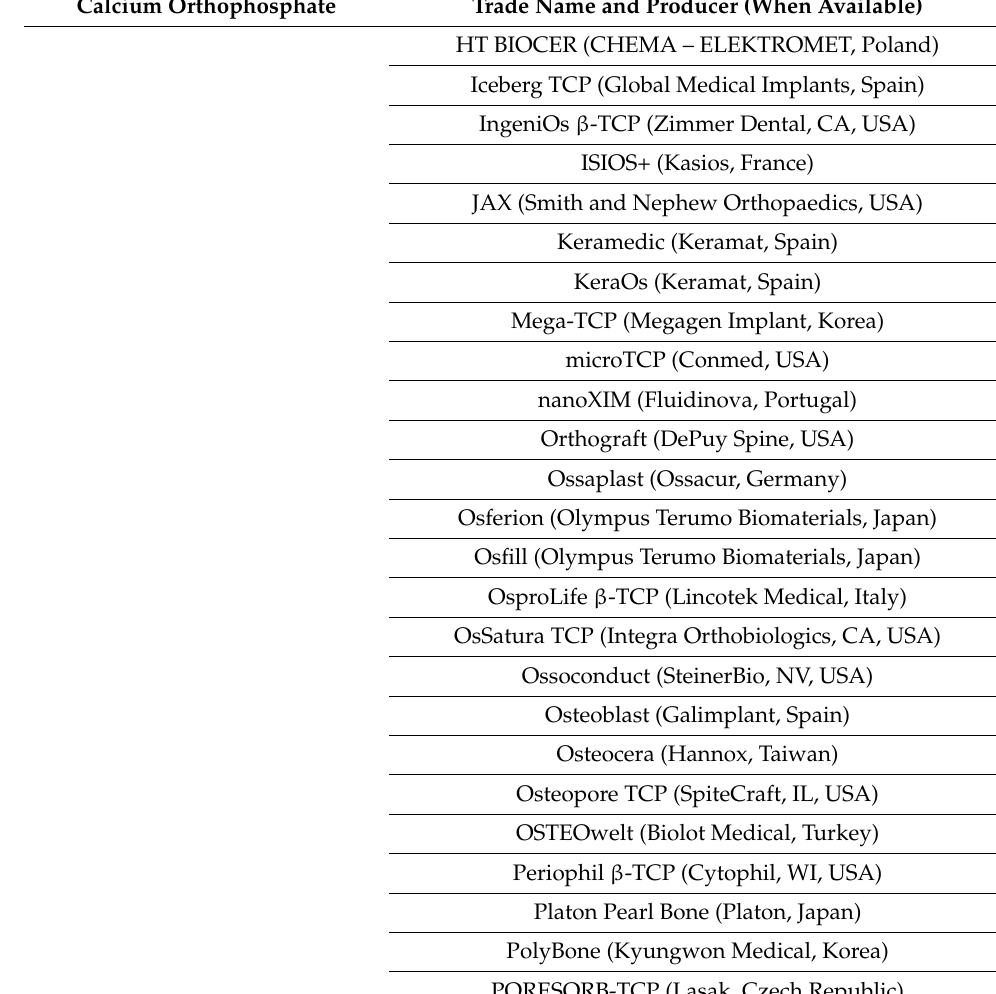
Table 3. Cont . Calcium